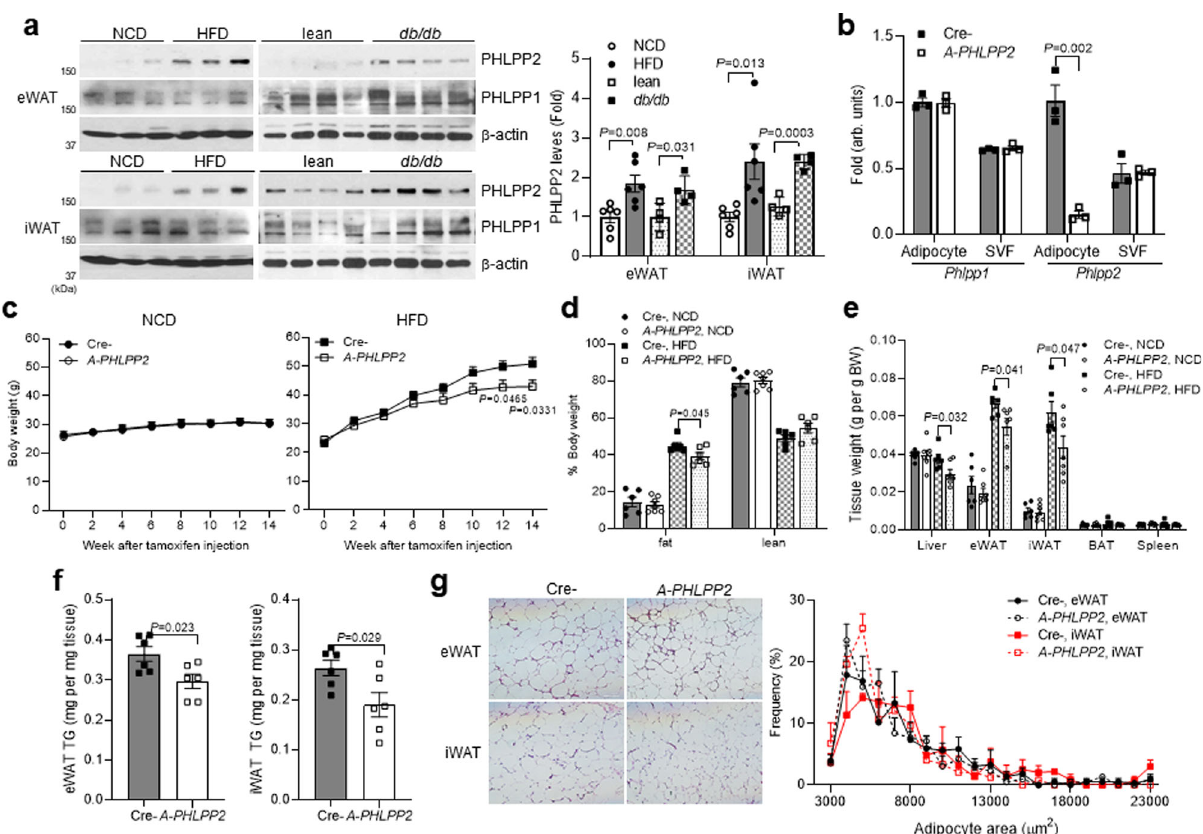
Fig. 1 Blocking adipocyte PHLPP2 attenuates HFD-induced adipocyte hypertrophy. a PHLPP1 and 2 protein levels in eWAT and iWAT from normal chow diet (NCD) or high-fat diet (HFD)-fed C57BL/6J, and lean or db/db mice, with quanti fi cation of PHLPP2 levels (right, n = 4 – 6 independent mice per group). b Gene expression in adipocytes and SVF isolated from eWAT from HFD-fed Cre- and A-PHLPP2 mice sacri fi ced after an 18 h fast ( n = 3 independent mice per group). c Body weight curves, d body composition, and e tissue weights in NCD-fed or HFD-fed Cre- PHLPP2 or A-PHLPP2 mice ( n = 6 – 7 independent mice per group). f eWAT and iWAT triglyceride (TG) content ( n = 6 independent mice per group), and g H&E staining (left) and adipocyte cell size- frequency distribution (right) ( n = 3 independent mice per group) in HFD-fed Cre- and A-PHLPP2 mice. Scale bars, 100 μ m. All data are shown as the means ± SEM. Statistical signi fi cance was determined by unpaired two-tailed Student ’ s t